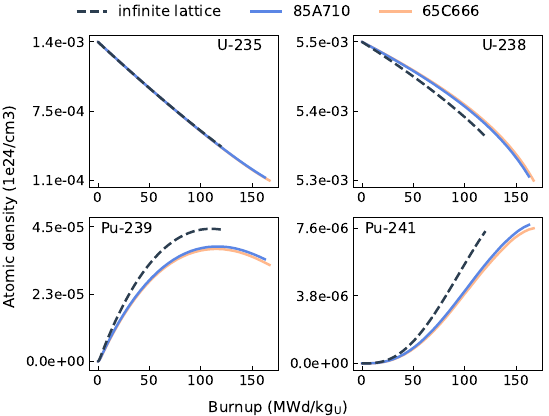
Figure 6. Comparison of assembly-wise atomic den- sities between the infinite lattice approximation and the unbroken burnup simulation of the opening step of the K216 cycle. Two fuel assemblies, standard 85A710 and control 65C666 , has been taken into the account in the latter type of the calculation. Values for 235 U, 238 U, 239 Pu and 241 Pu are